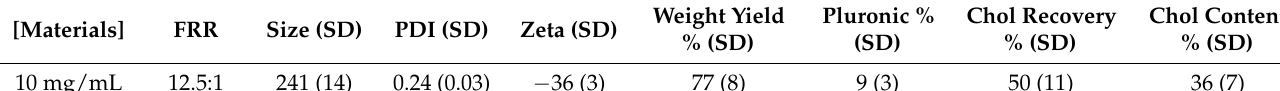
Table 1. Physico-chemical characterization of H-NMeds obtained by the nanoprecipitation benchtop protocol. Standard Deviation (SD) is reported in parentheses.